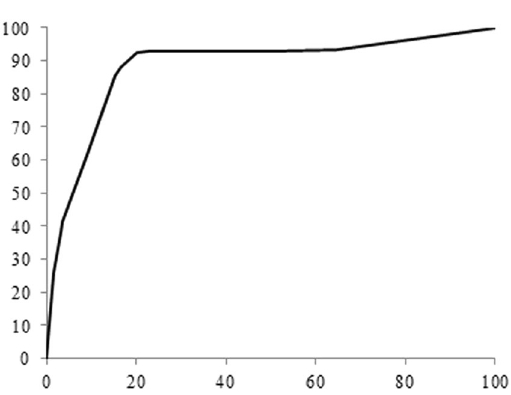
Figure 11. ROC graph for showing the overall performance of the proposed methodology.